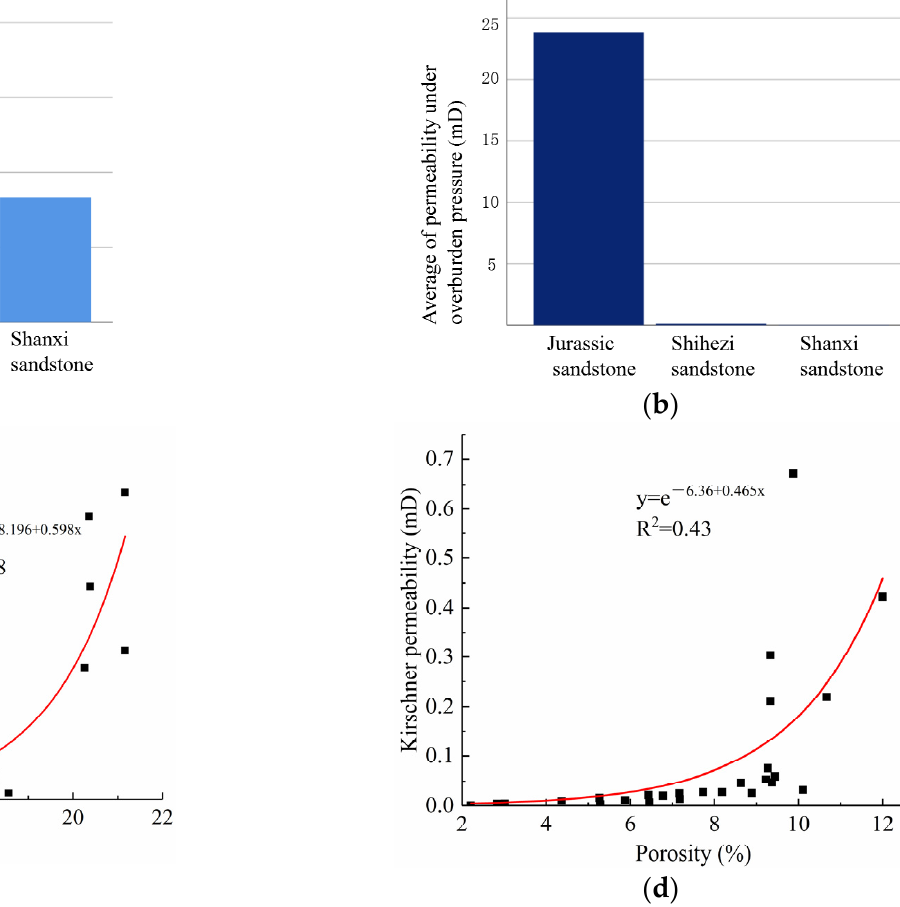
Figure 6. The comparisons and correlations of porosity and permeability: ( a ) The porosity comparisons of the three layers of sandstone. ( b ) Permeability comparisons of the three layers of sandstone. ( c ) The correlation between porosity and permeability in the Jurassic sandstone. ( d ) The correlation between porosity and permeability in the Permian sandstone.